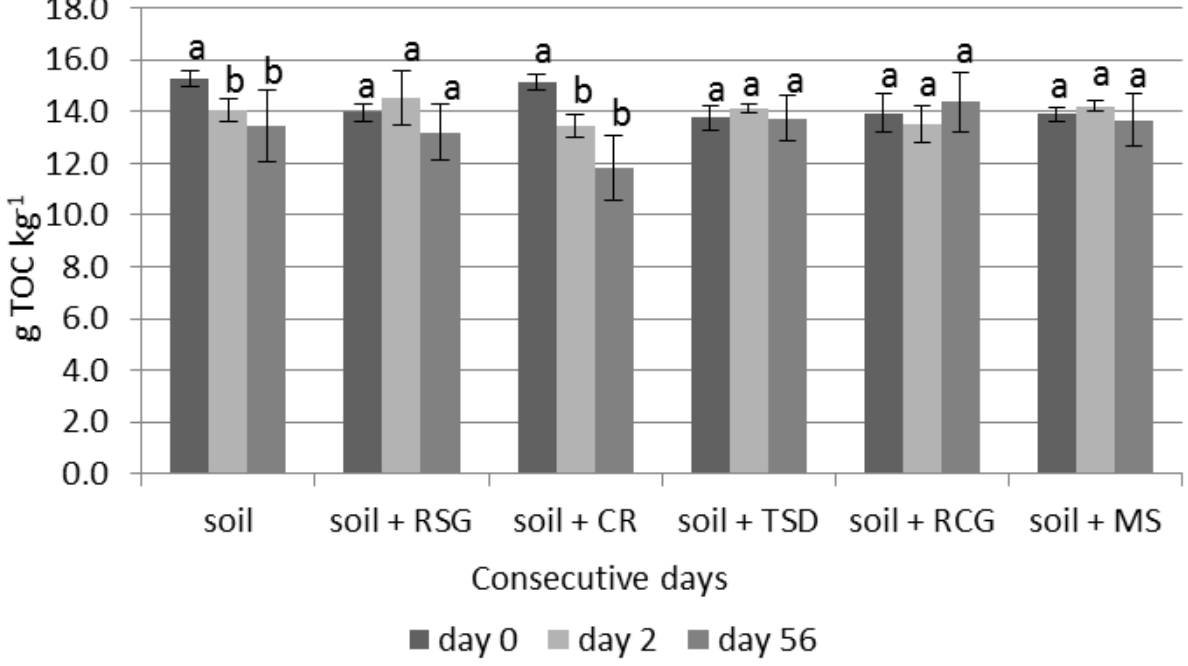
Figure 3. TOC content (mean value ± standard deviation) in the control (soil) and in soil treated with reed sweet-grass digestate (RSG), common reed digestate (CR), tufted sedge digestate (TSD), reed canary grass digestate (RCG) and maize digestate (MS). Different letters indicate significant differences in particular treatments (p < 0.05) according to Tukey’s test. Table 4. Mean EC (µS cm -1 ) at different times during the incubation. Control = soil without amendments, RSG = soil fertilised with anaerobically digested reed sweet-grass, CR = soil fertilised with common reed digestate, TSD = soil fertilised with tufted sedge digestate, RCG = soil fertilised with reed canary grass digestate, MS = soil fertilised with maize digestate. Different appended letters indicate significant differences among treatments (p < 0.05) according to Tukey’s